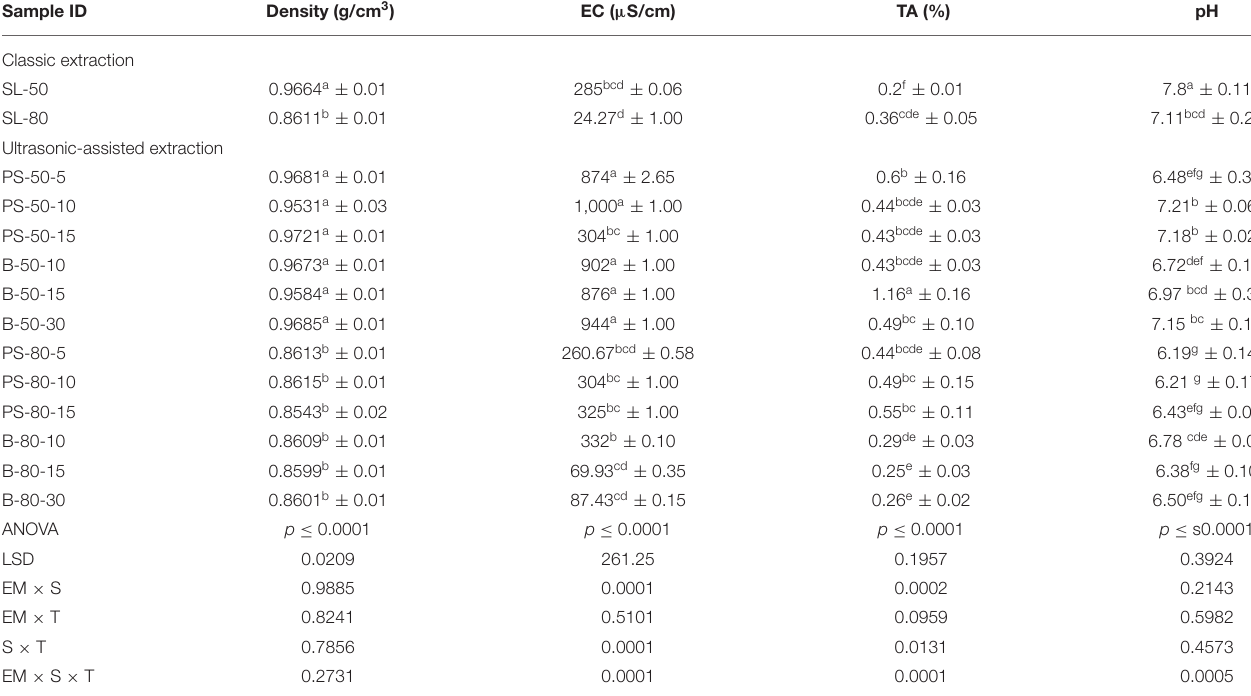
TABLE 4 | Physicochemical parameters of nettle alcoholic